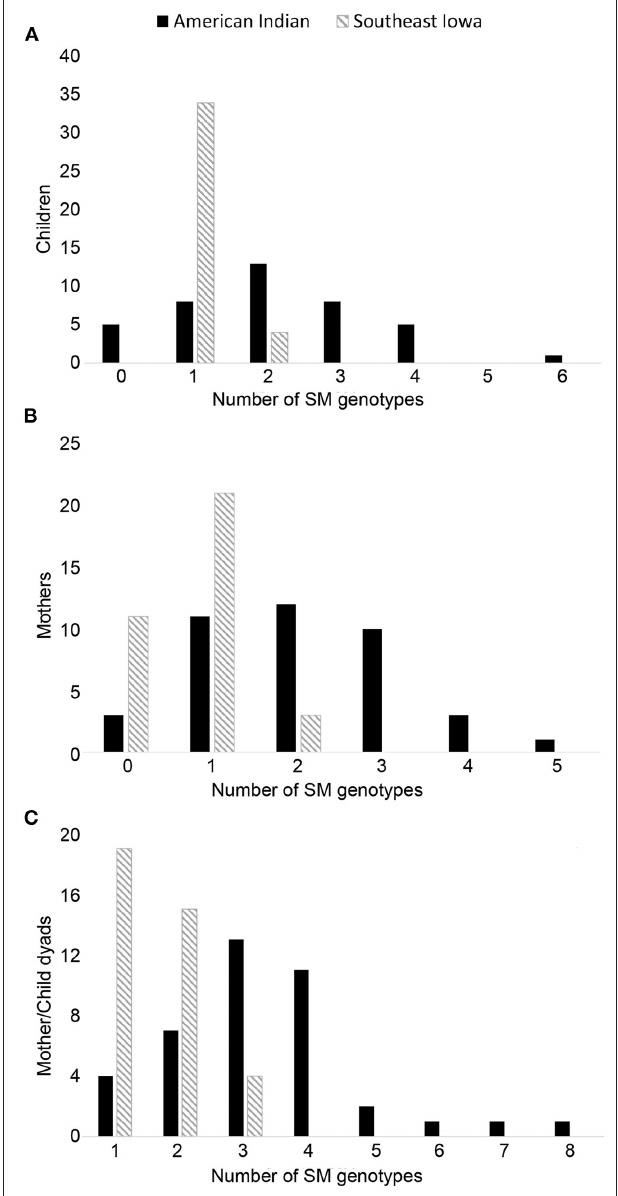
FIGURE 1 | Diversity of S. mutans (SM) genotypes in subjects with S. mutans detected. Aggregate data, divided by population, showing the number of individual subjects and dyads displaying a specific number of unique S. mutans genotypes. Data are (A) children only, (B) mothers only, and (C) mother-child dyads (total number of genotypes found within the pair).